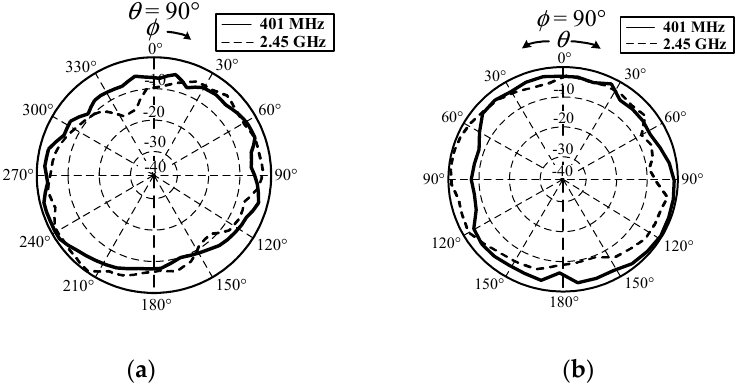
Figure 16. Measured radiation patterns of MICS/ISM meander-line microstrip antenna in equivalent liquid mixtures 2 and 4: ( a ) xy and ( b ) yz planes.